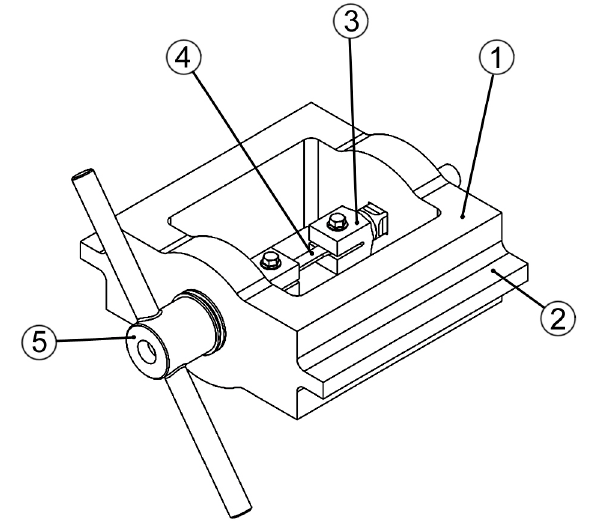
Figure 2. Testing fixture: 1) load frame, 2) stiffener, 3) forks with threaded ends, 4) specimen, 5) loading nut.